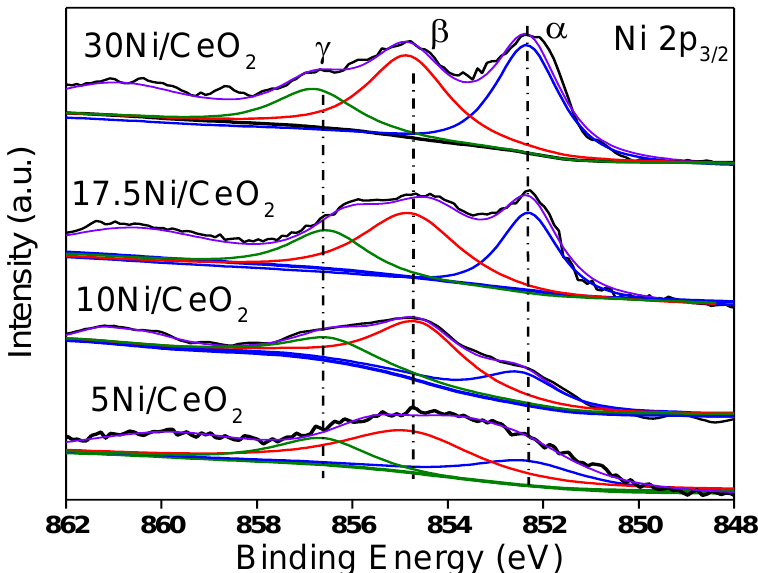
Figure 7. The Ni 2p 3/2 core-level XPS spectra of the xNi/CeO 2 catalysts. The H 2 -TPD characterization results of the CeO 2 support and each catalyst are